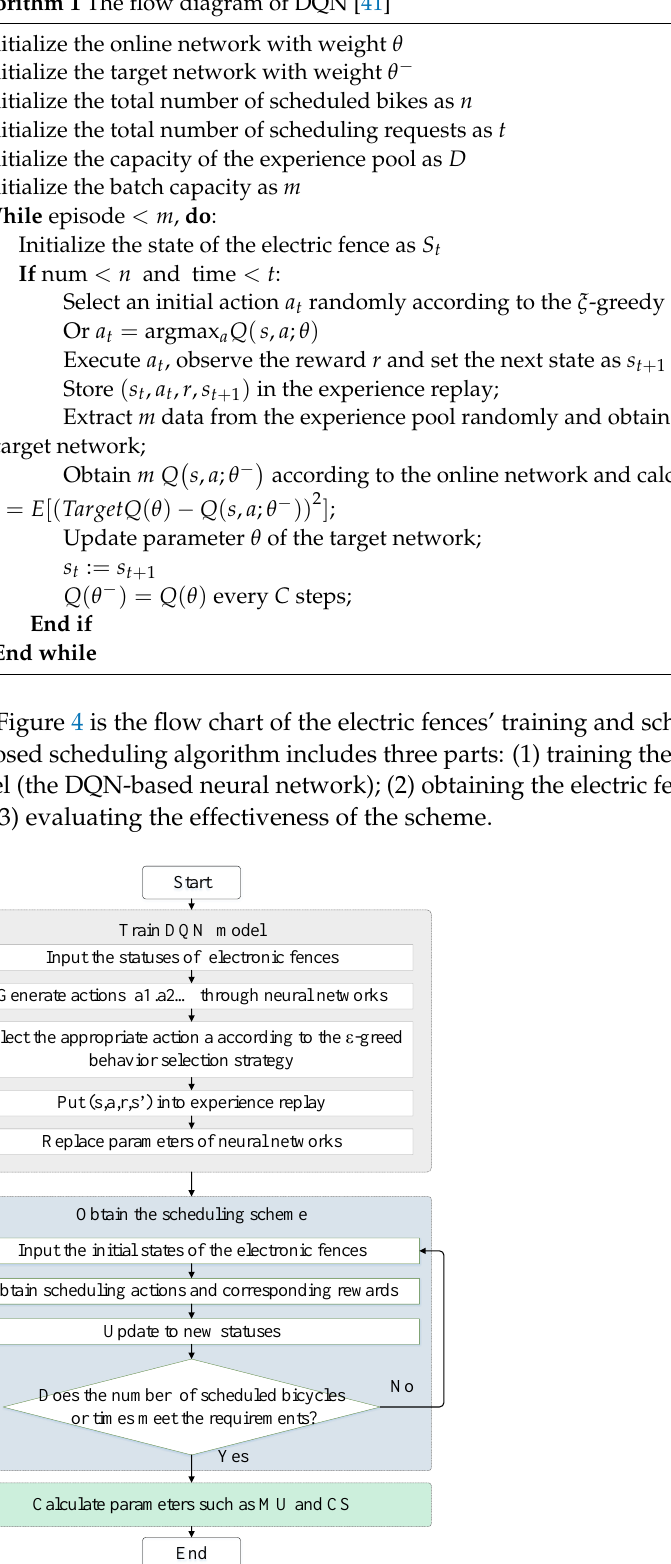
Algorithm 1 The flow diagram of DQN [41]